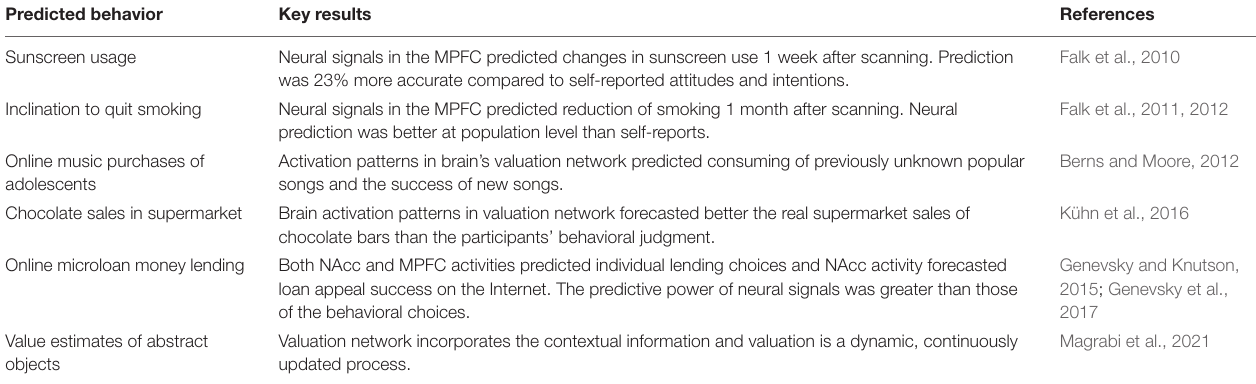
TABLE 2 | Selected neuroscience studies that demonstrate the existence of the brains’ valuation network and how its signal can predict real behavior of humans. Predicted behavior Key